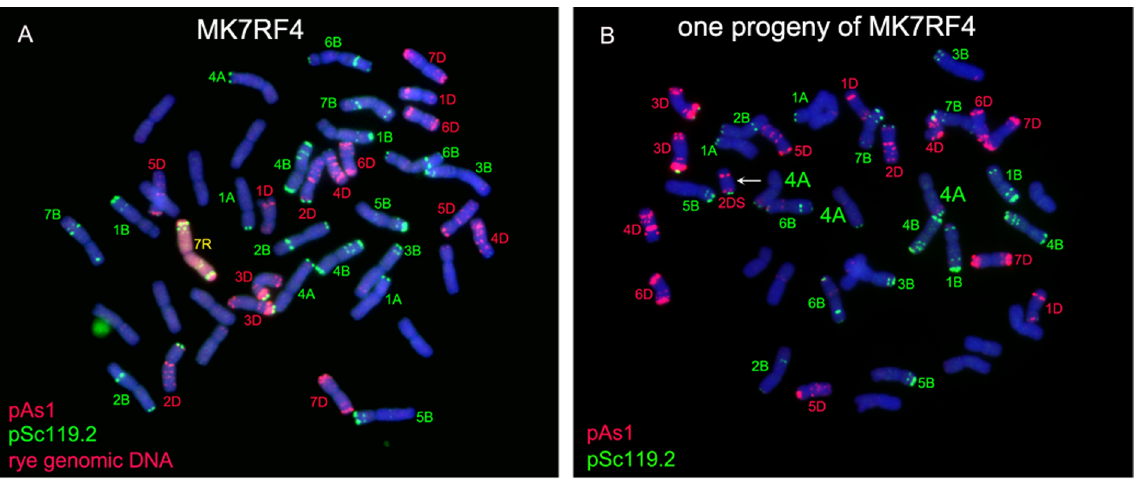
Figure 3. FISH and GISH using pAs1 (red), pSc119.2 (green) and rye genomic DNA (red) as probes on 7R monosomic addition line and its selfed progeny. A FISH and GISH analyses on the chromosomes of MK7RF 4 . B FISH and GISH analyses on the chromosomes of one of the selfed progeny of MK7RF 4 and GISH signals can not be observed. The three 4A chromosomes are marked. Arrow indicates the broken 2D chromosome. Chromosomes were counterstained with DAPI (blue).